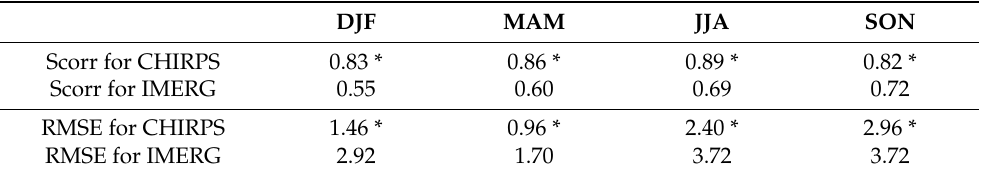
Figure 4. Spatial distribution of seasonal mean precipitation over Taiwan averaged during 2001–2019 for the winter (DJF), spring (MAM), summer (JJA) and autumn (SON) extracted from ( a ) CWB, ( b ) CHIRPS, and ( c ) IMERG. Table 5. Spatial correlation coefficient (Scorr) and root mean square error (RMSE; unit: mm · d − 1 ) for comparison between CWB and two SPPs in Figure 4. CHIRPS/IMERG with higher value of Tcorr or lower value of RMSE are marked by * for individual season.